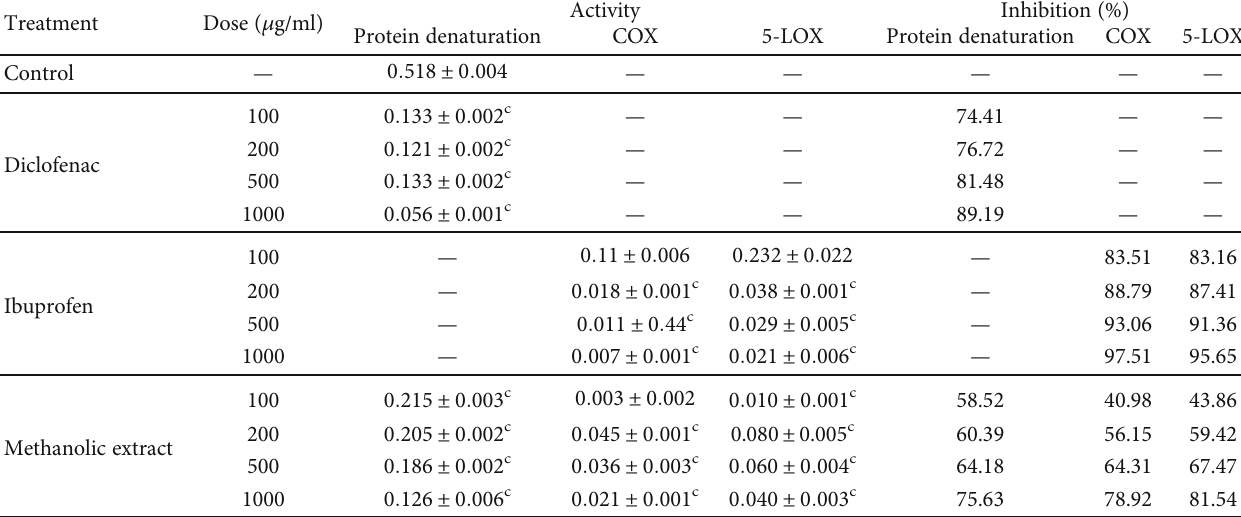
Table 1: E ff ect of methanolic extract of D. benthamianus stem bark on protein denaturation, cyclooxygenase, and 5-lipoxygenase inhibition. Treatment